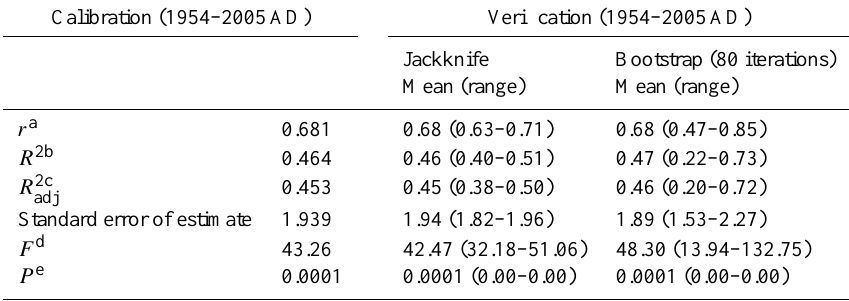
Table 1. Statistics of the regression model.